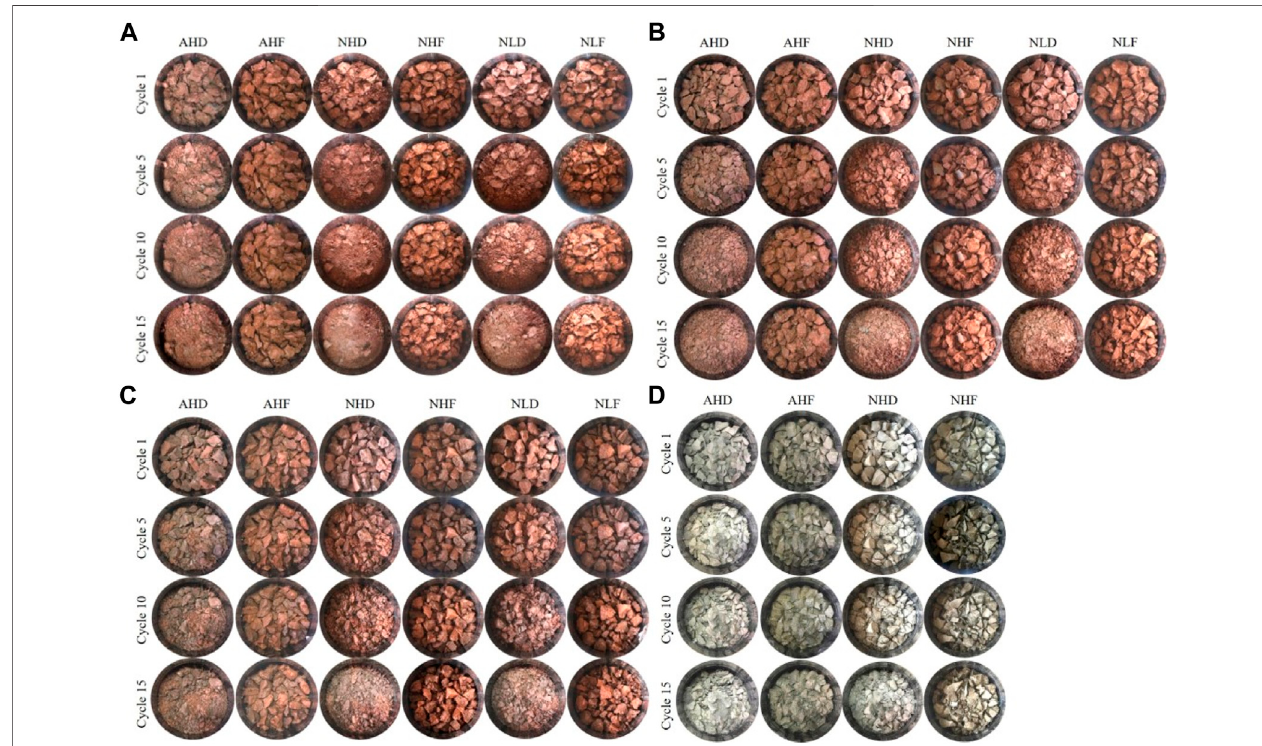
FIGURE 3 | Four types of soft rocks exposed to cycles 1, 5, 10, and 15 of six treatments of different temperatures, rainfall intensities, and acidities. (A) D sample from Datang badlands, China; (B) J sample from Jiangtian badlands, China; (C) X sample from Xiahui badlands, China; (D) A sample from Araguás badlands, Spain. Codes of treatments are N — natural rain and A — acid rain; H — high intensity and L — low intensity; D — drying temperature and F — freezing temperature.